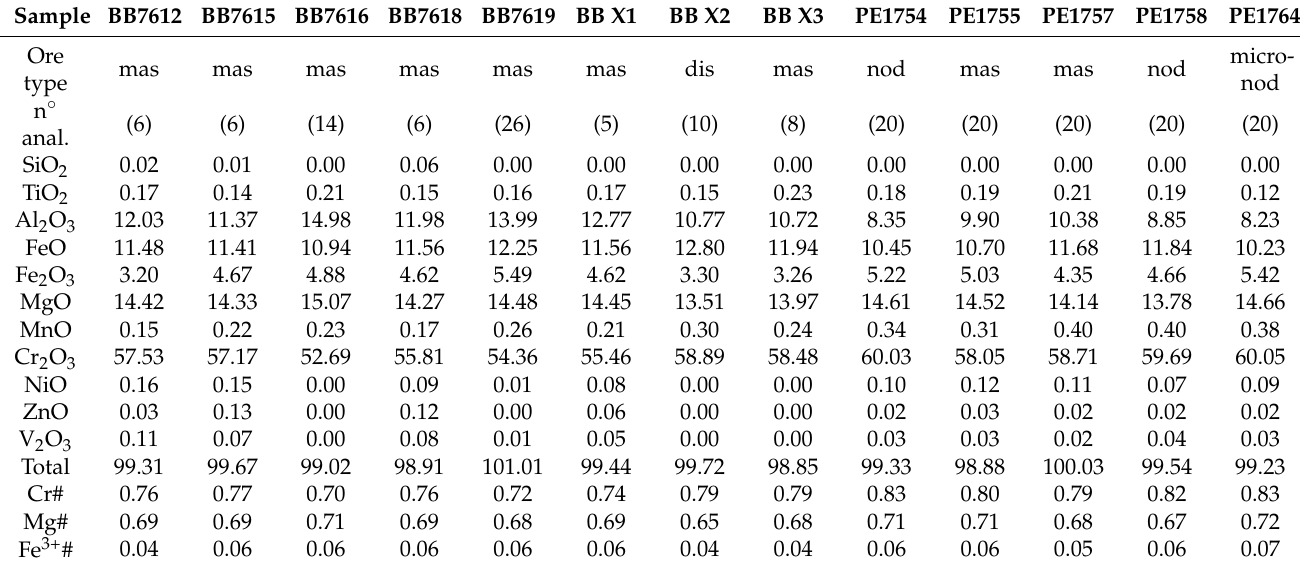
Table 1. Electron microprobe compositions (wt%) of chromite from chromitites of the the Kraka ophiolite complex.